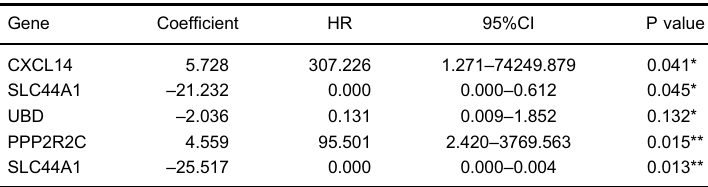
Four SDGs were related with overall survival and used to calculate the risk score to classify the tumor patients into high- and low-risk groups. *DSS-related prognostic SDGs; **PFS-related prognostic SDGs. Risk score ¼